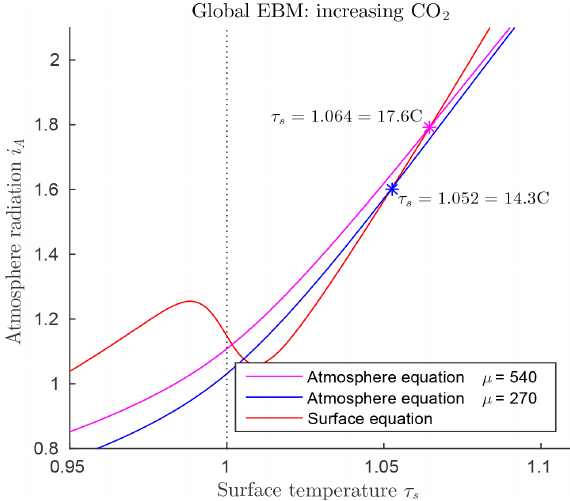
Figure B1. Equilibrium climate sensitivity (ECS) for millennial data. The equilibrium points marked with stars show the change in T S for a doubling of µ from 270 to 540ppm; T S (270) = 14 . 3, T S (540) = 17 . 6 and (cid:49)T = 3 . 3 ◦ C.